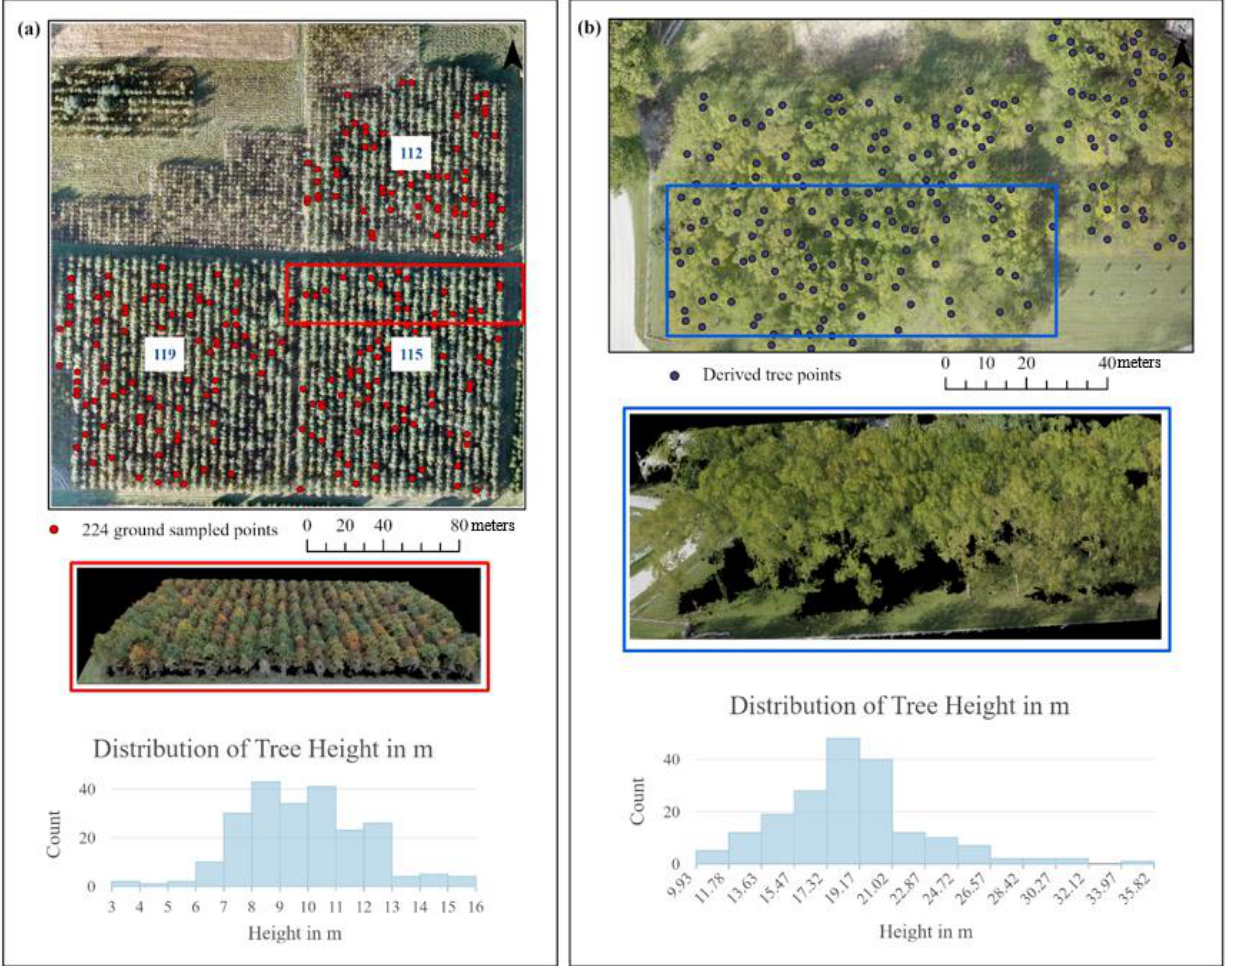
Figure 1. Orthomosaic and point cloud illustration of the two plantations in this study, ( a ) red oak plantation and ( b ) black walnut plantation, with their tree height statistics, at Martell Forest, Indi- ana. Table 2. Summary of parameter specifications for two platforms and sensors used for this study.